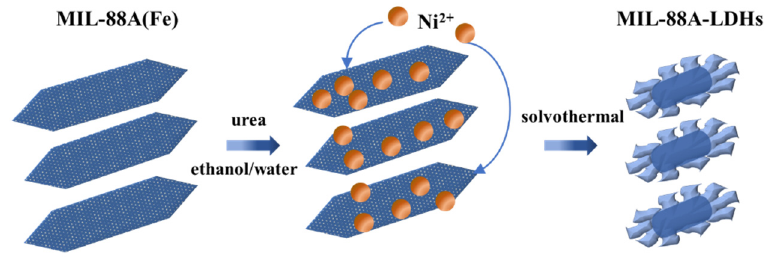
Figure 10. Schematic illustration of the synthesis process of MIL-88A-LDHs.